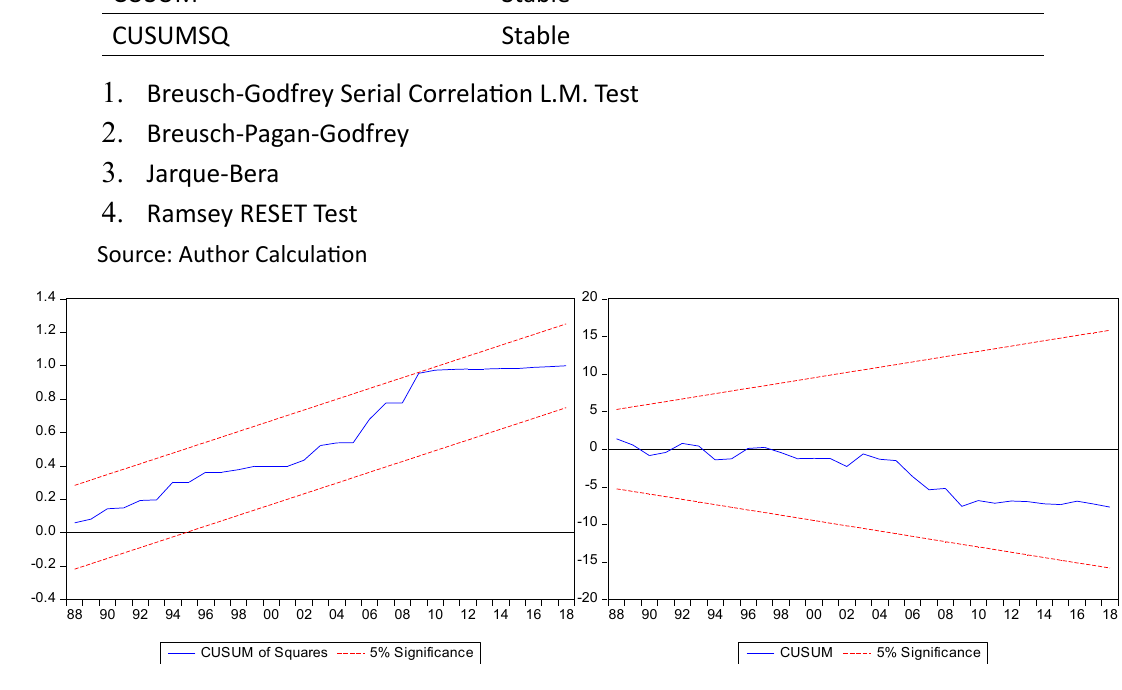
Figure 3.CUSUM and CUSUM of Square Plots for the Model Stability.